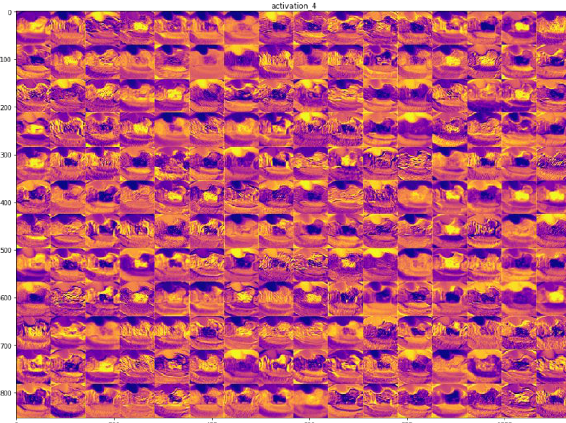
Figure 9(b). Saliency map for activation